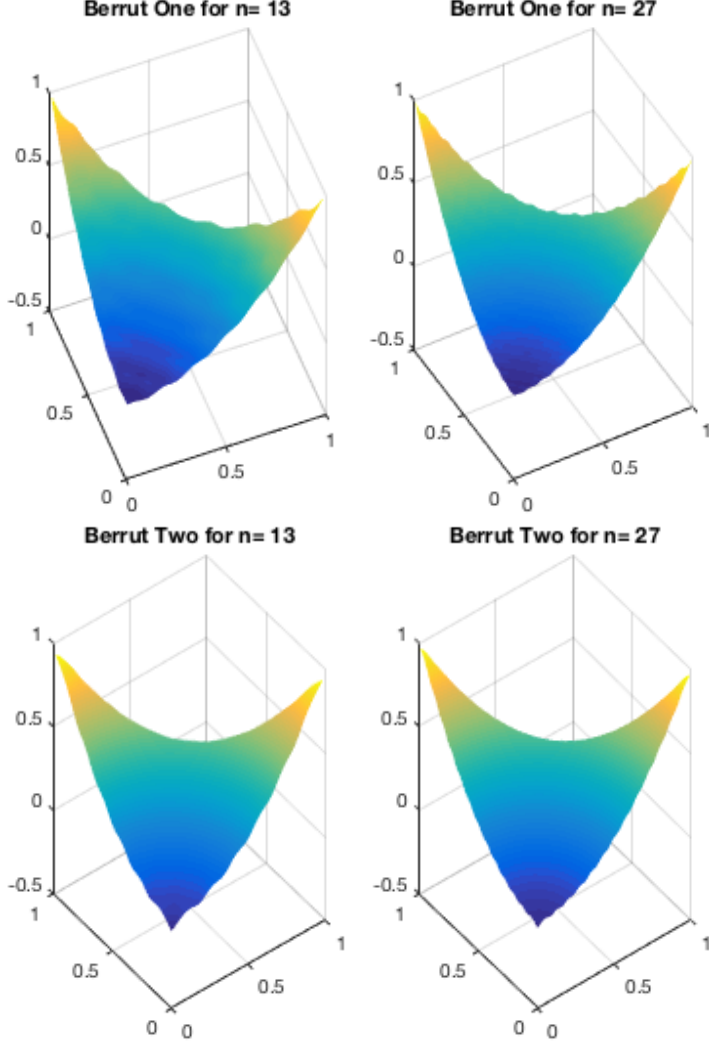
Figure 10. Above: Berrut’s one. Below: Berrut’s